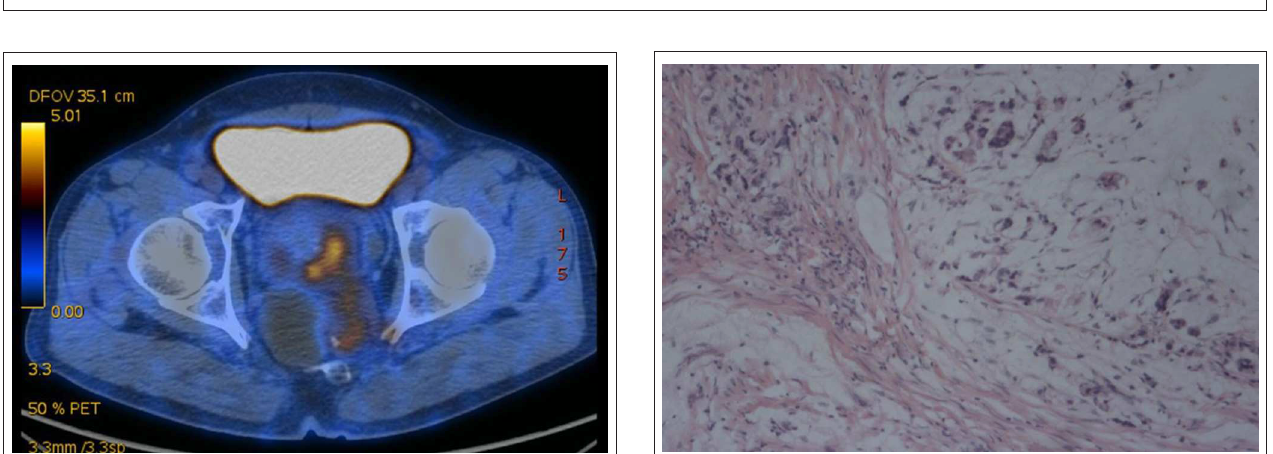
due to its location adjacent to the anus. CT and PET-CT revealed